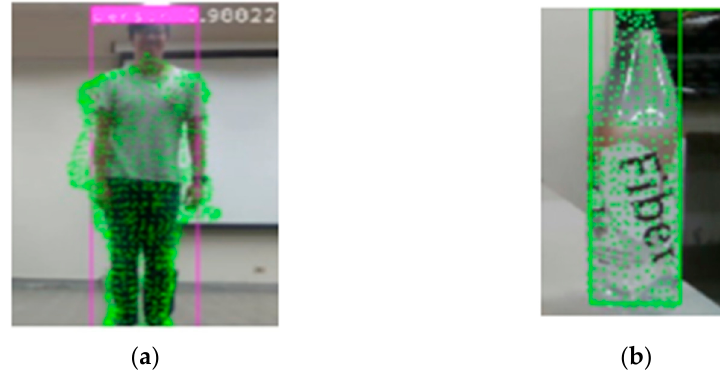
Figure 9. Point cloud images of ( a ) a customer and ( b ) a bo tt le.